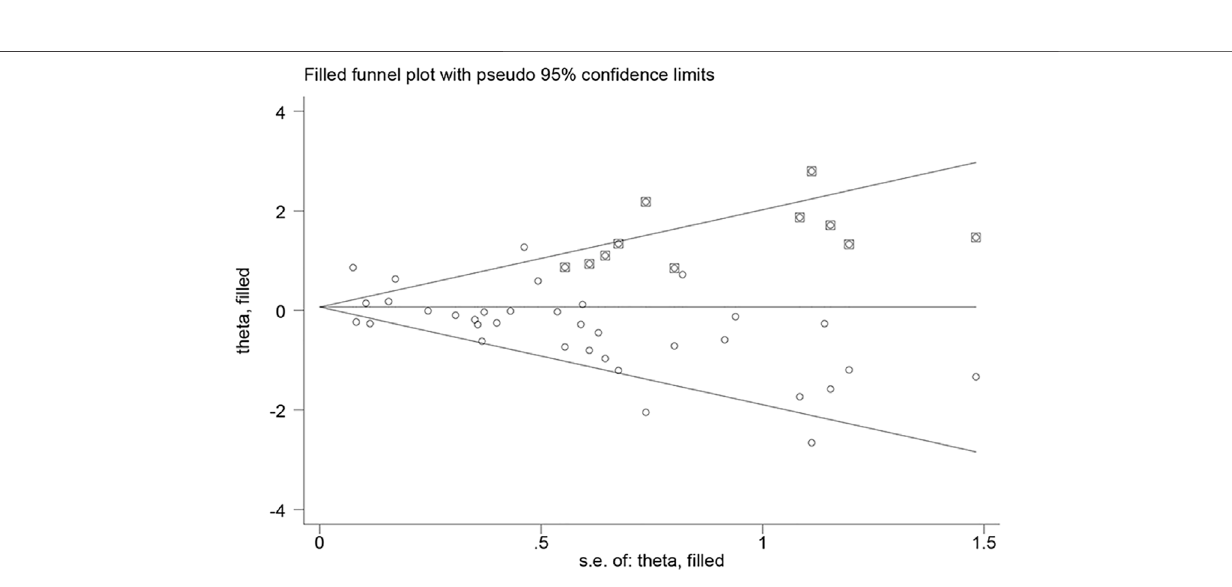
Frontiers in Pharmacology |